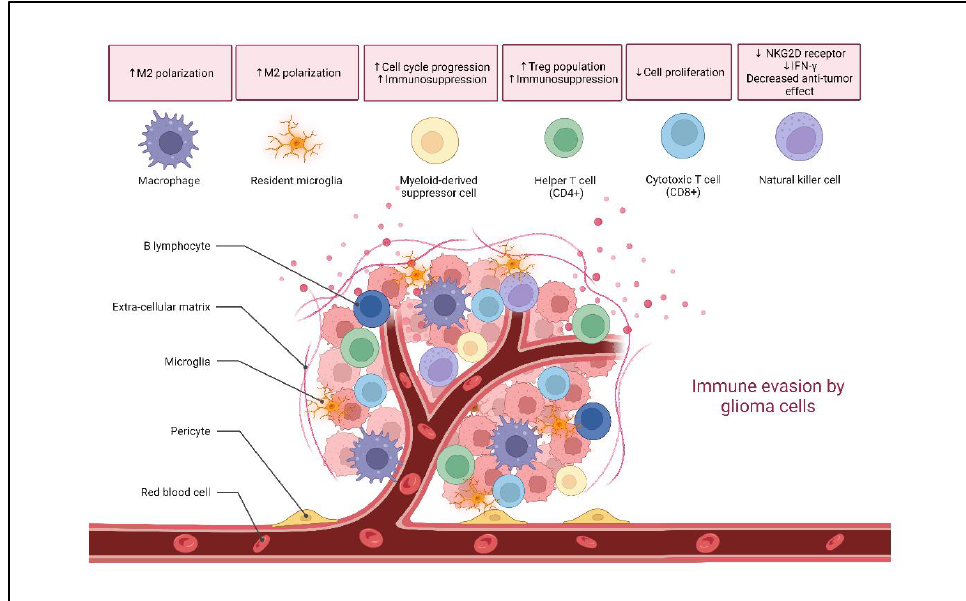
Figure 1. Effect of tumor cells on glioma immune landscape. Glioma cells modulate immune cell functions in the tumor microenvironment, resulting in an immunosuppressive phenotype through secretion of various factors. Therefore, activation of NK and CD8+ T cell is downregulated. Further, the immunosuppressive environment is supported by macrophages polarizing to an anti-inflammatory M2 state and recruitment of MDSCs and Tregs. Created with BioRender.com (accessed on 14 March 2023).